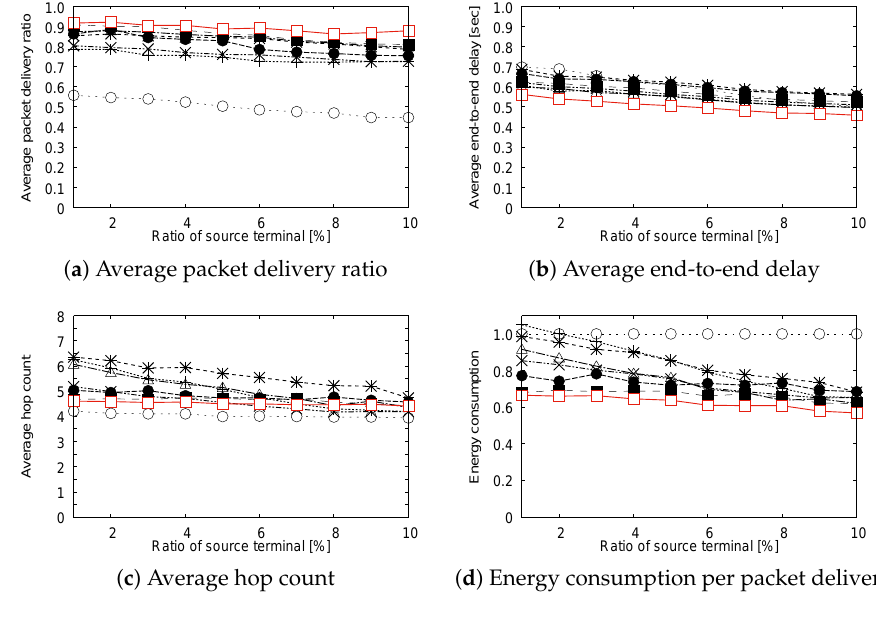
Figure 5. Results of Simulation